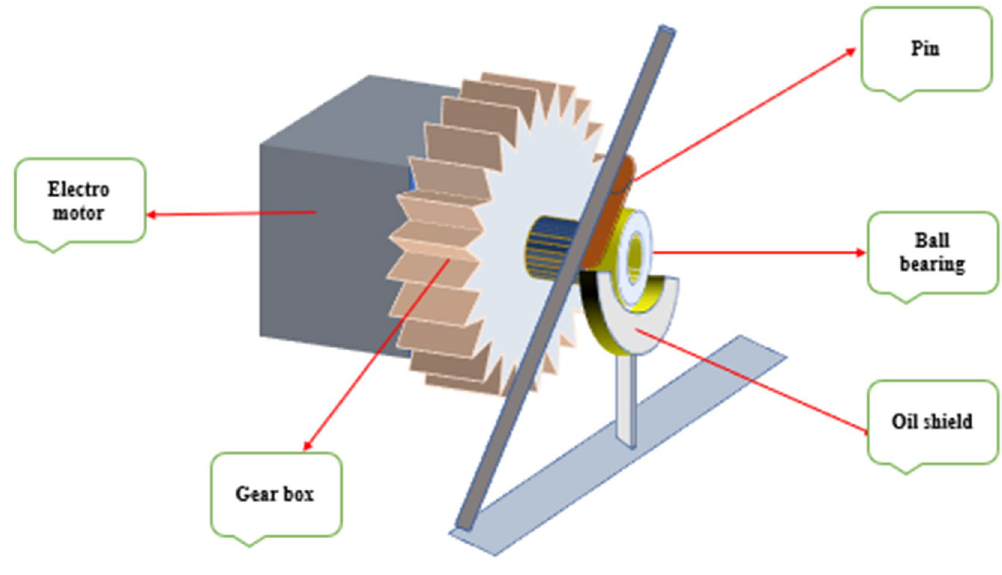
Figure 2. Schematic of the wear